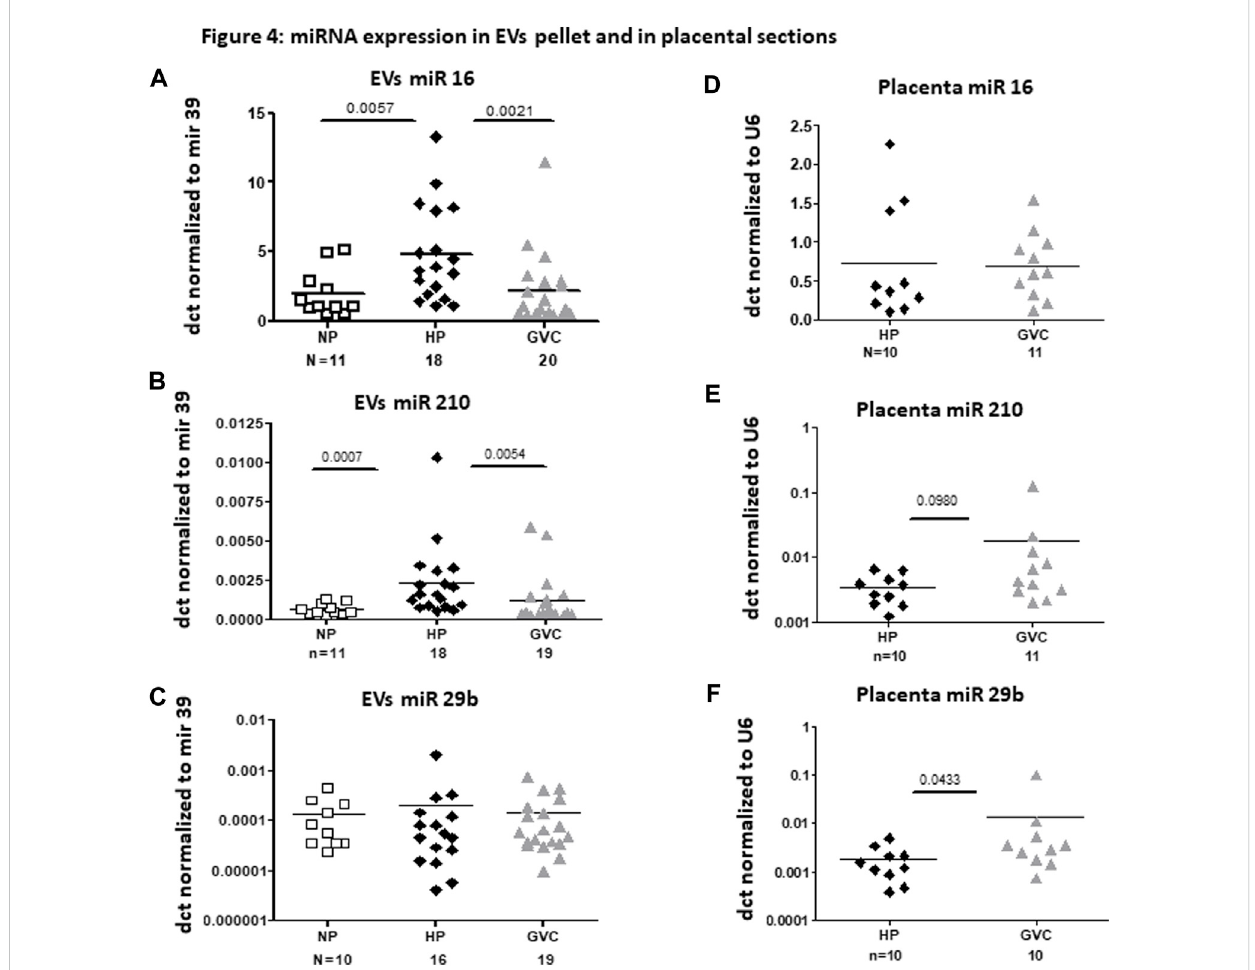
FIGURE 4 miRNA expression in EV pellet and placental sections from the study groups miRNA expression in EV pellets of the non-pregnant group, and EV pellets and placental sections of the pregnant groups [healthy-pregnant (HP) and gestational vascular complications (GVC)] were validated by real-time polymerase chain reaction. Each EV miRNA sample was normalized to cel-mir-39 spike-in. Each placental miRNA sample was normalized to U6, and expressed as dct. (A – C) present expression of the following miRNA EVs: hsa-miR16 (A) , hsa-miR210 (B) , and hsa-mir29b-5p (C) . (D – F) present expression of these miRNAs in placental sections: hsa-miR16 (4 days), hsa-miR210 (E) , and hsa-mir29b-5p (F) .